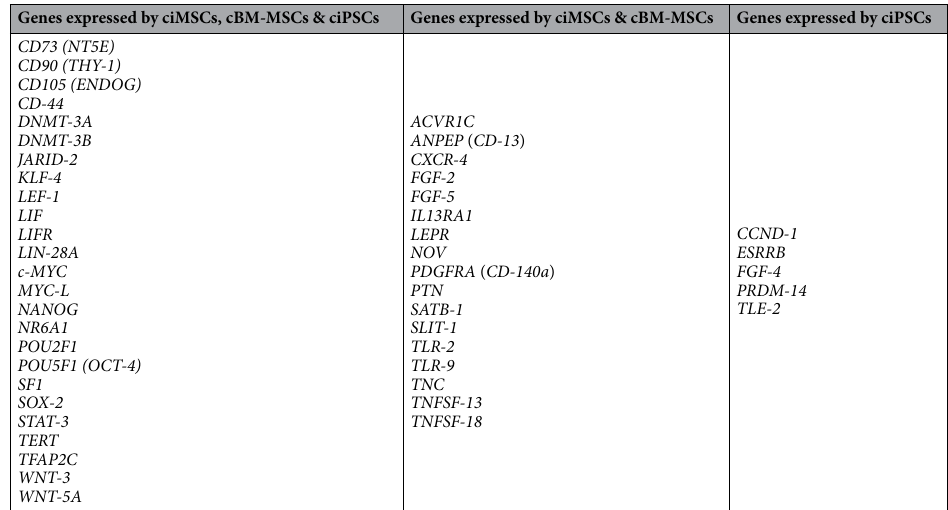
Table 1. Key genes expressed by each of ciMSCs, cBM-MSCs and ciPSCs.